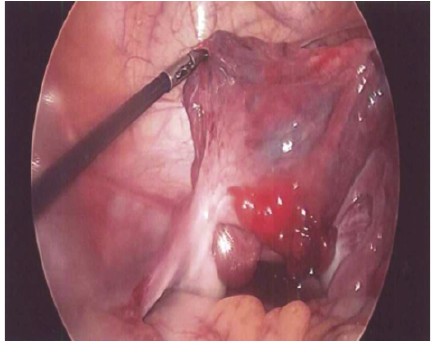
Figure 2: Laparoscopic view of detorsioned left fallopian tube with paratubal hydatid of